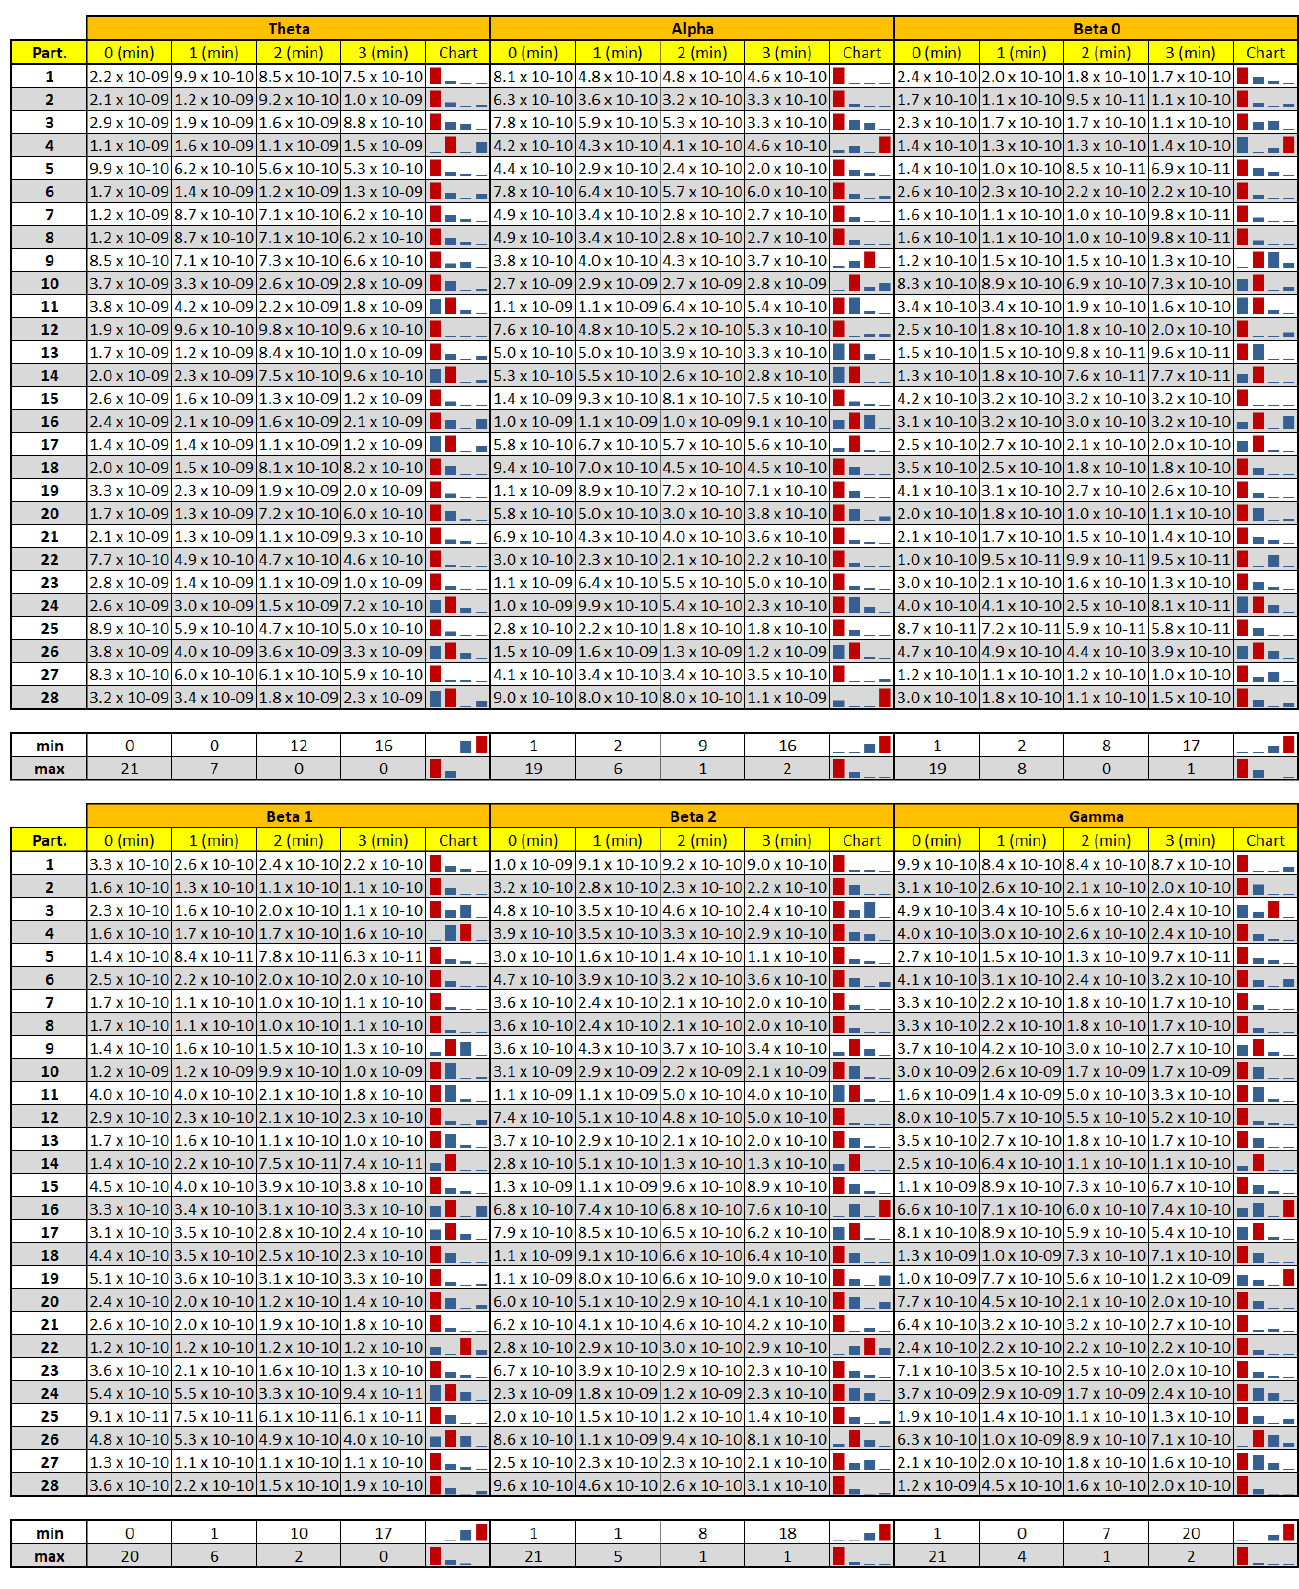
Figure A4. Average GFP values for individual brain waves and for individual participants calculated for relaxation. The means were counted for four minutes: 0 (min)—average for the minute before the event; 1, 2, 3 (min)—average for the consecutive minutes of the event. The number of minimum and maximum values for individual participants was summarized under the